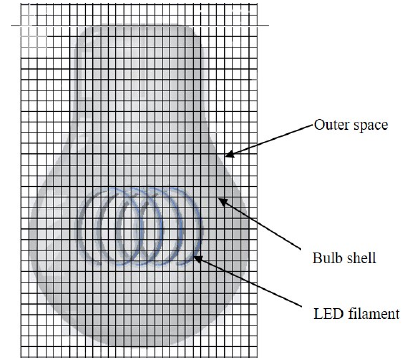
Figure 5. Mesh of the numerical simulation model.